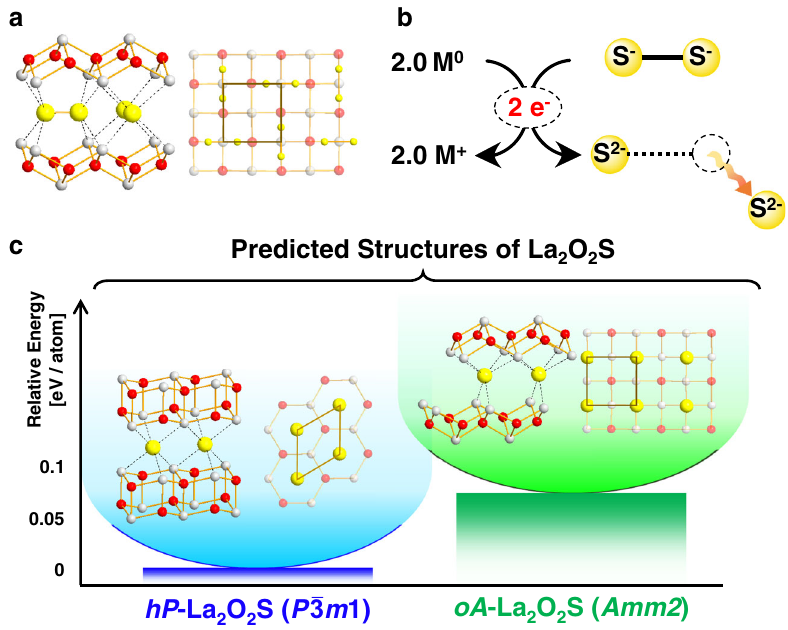
Fig. 1 Topochemical reactivity of La 2 O 2 S 2 . a Structure of La 2 O 2 S 2 reported by Ostorero et al. (SG: Cmca ) 18 . Lanthanum, oxygen, and sulfur atoms are represented by white, red, and yellow balls, respectively. b Conceptual scheme of S – S bond cleavage under the donation of one electron per elemental metal M 0 that triggers subsequently the deintercalation of half sulfur atom of the S 2 dumbbell that possibly enables topochemical conversion of La 2 O 2 S 2 into the new polymorph of La 2 O 2 S. c The two low-energy dynamically stable phases of La 2 O 2 S predicted by USPEX that are separated by 72